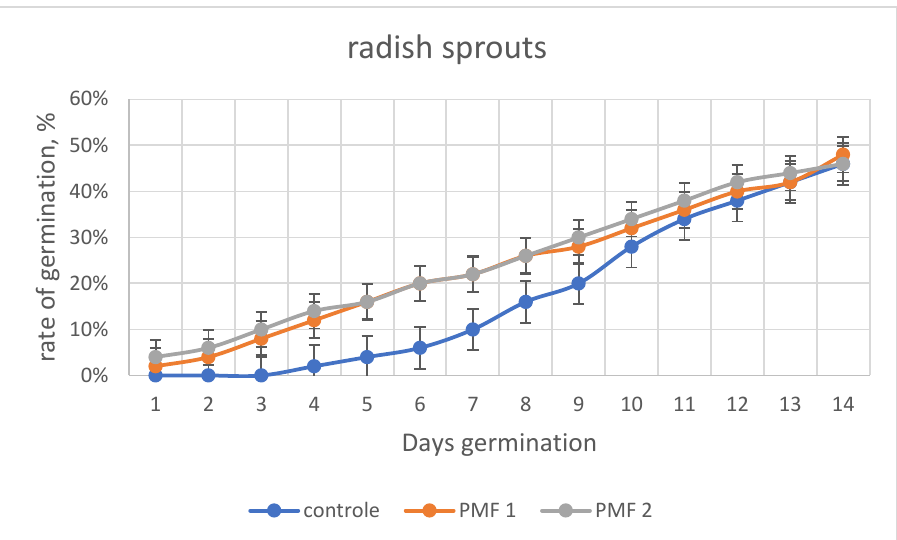
Figure 3. Radish sprout germination dynamics for the control sample and for magnetic field 1 (PMF 1 – 100 µT and 100 Hz) and magnetic field 2 (PMF 2 –100 µT and 200 Hz), mean standard error α = 0.05.